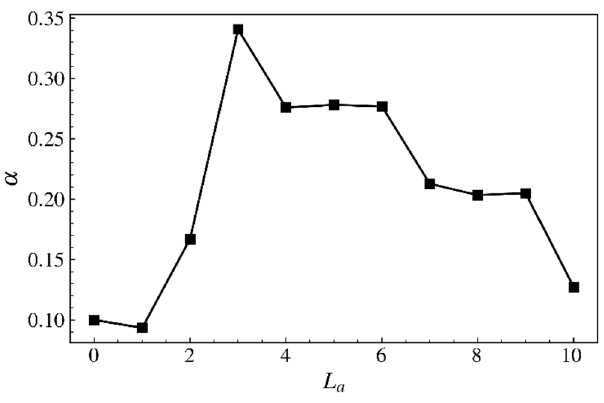
. γ α (see Figure 9) for various comb polymers as G α γ  (see Figure 9) for various comb polymers xx